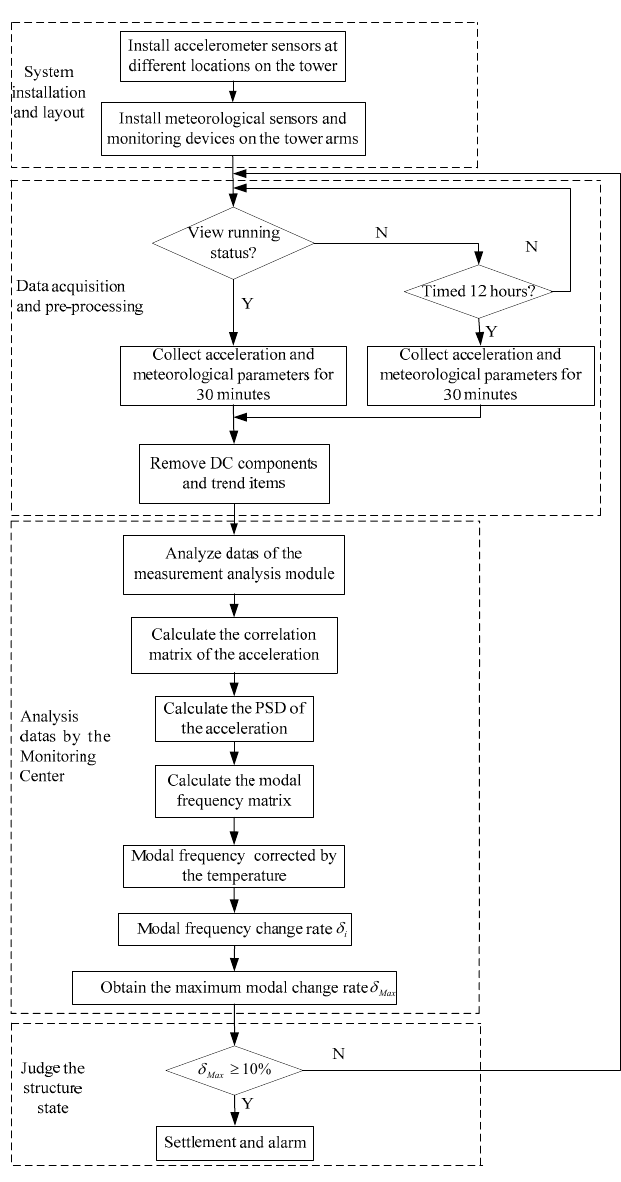
Figure 15. Flow chart of the system.